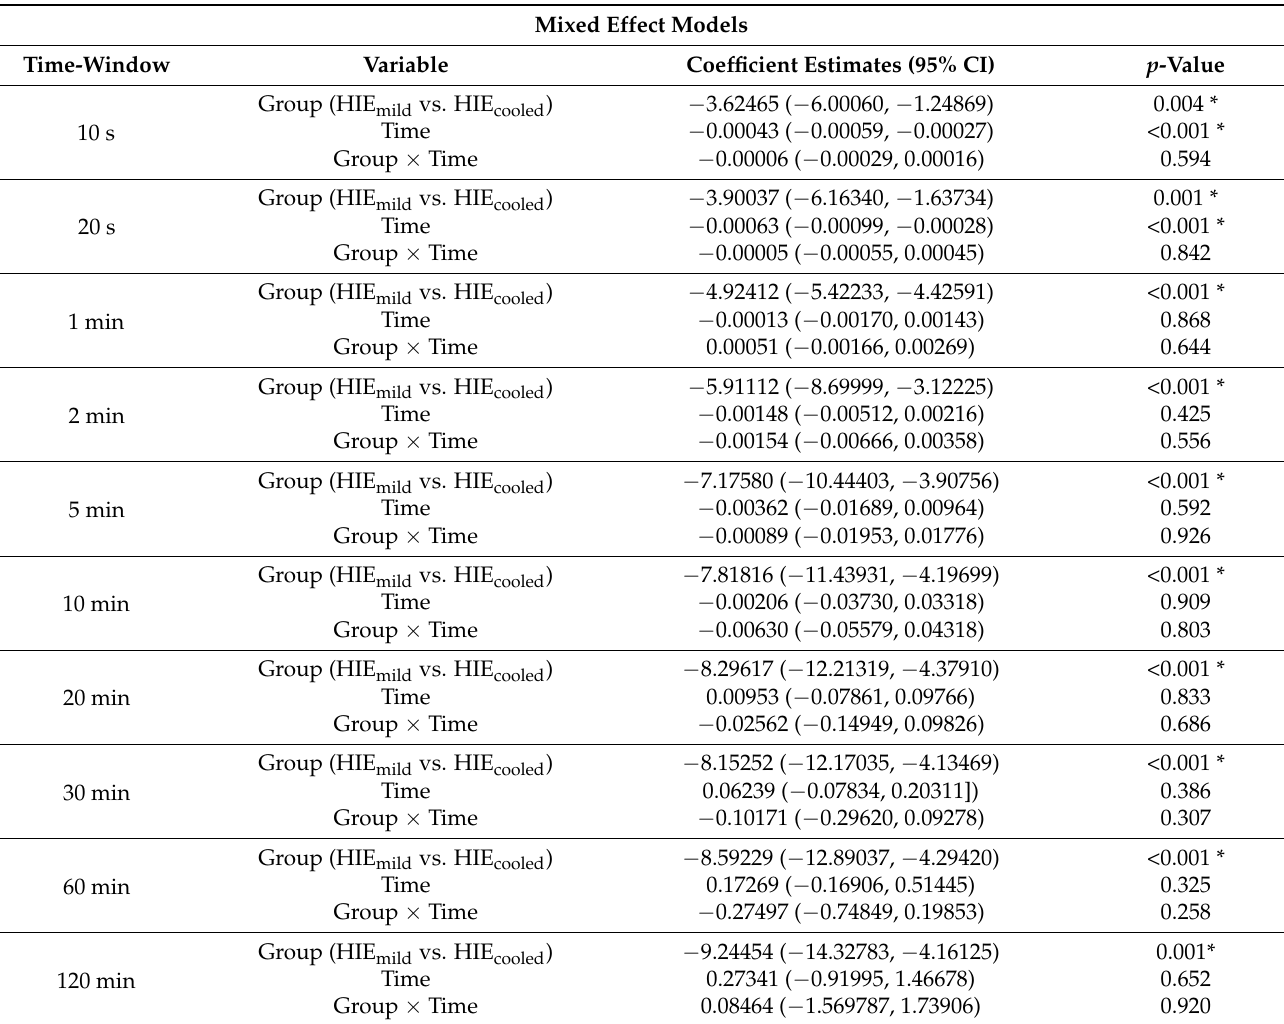
Table 2. Mixed-effects models for different window sizes on